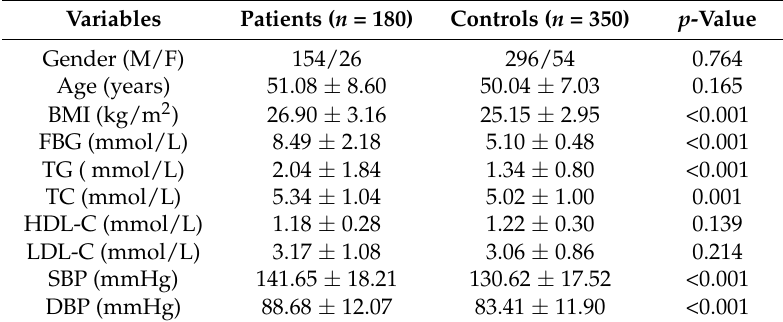
Table 1. Demographic and clinical characteristics of study subjects ( n = 530). Variables Patients ( n = 180) Controls ( n =